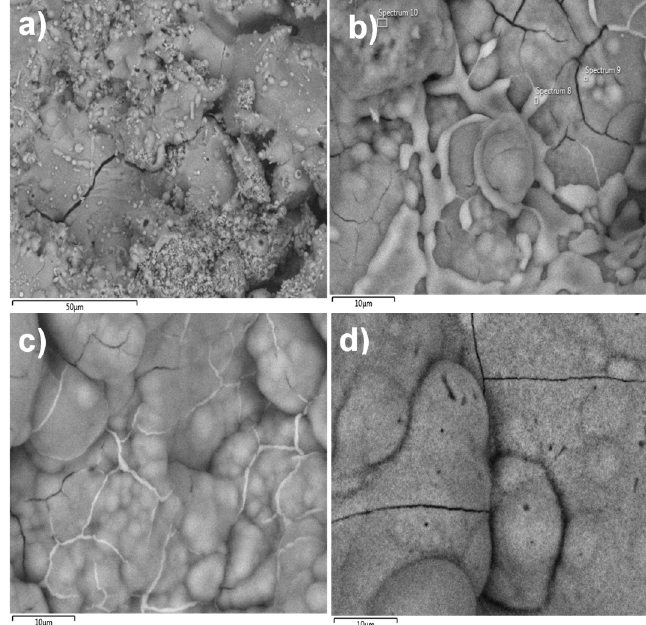
Figure 4. SEM micrographs of the HA/Ag-NPs coating exposed to simulated body fluid (SBF): ( a ) 1 h, ( b ) 12 h, ( c ) 24 h, and ( d ) 30 days.